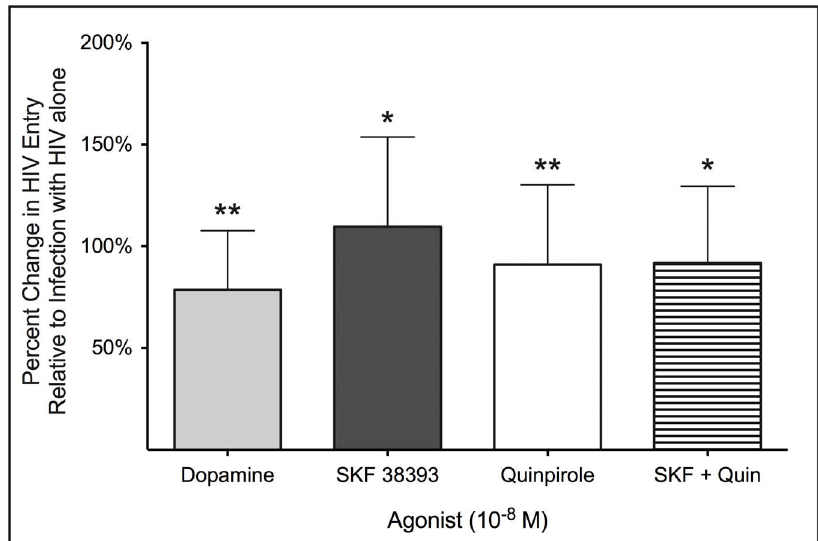
Figure 5. Activation of both D1-like and D2-like dopamine receptors is capable of mediating increased HIV entry. Macrophages were infected with b -lac HIV (MOI 0.01) in the presence of either 10 8 M dopamine (light gray), a D1-like DR agonist (10 8 M SKF 38393, dark gray), a D2-like DR agonist (10 8 M Quinpirole, white), both SKF 38393 and Quinpirole together (horizontal lines). Macrophages infected with HIV alone served as controls. Dopamine, SKF 38393, Quinpirole and SKF 383893 + Quinpirole all significantly increased viral entry relative to infections with HIV alone (n=10, * p . 0.05, ** p . 0.01 vs. HIV alone).